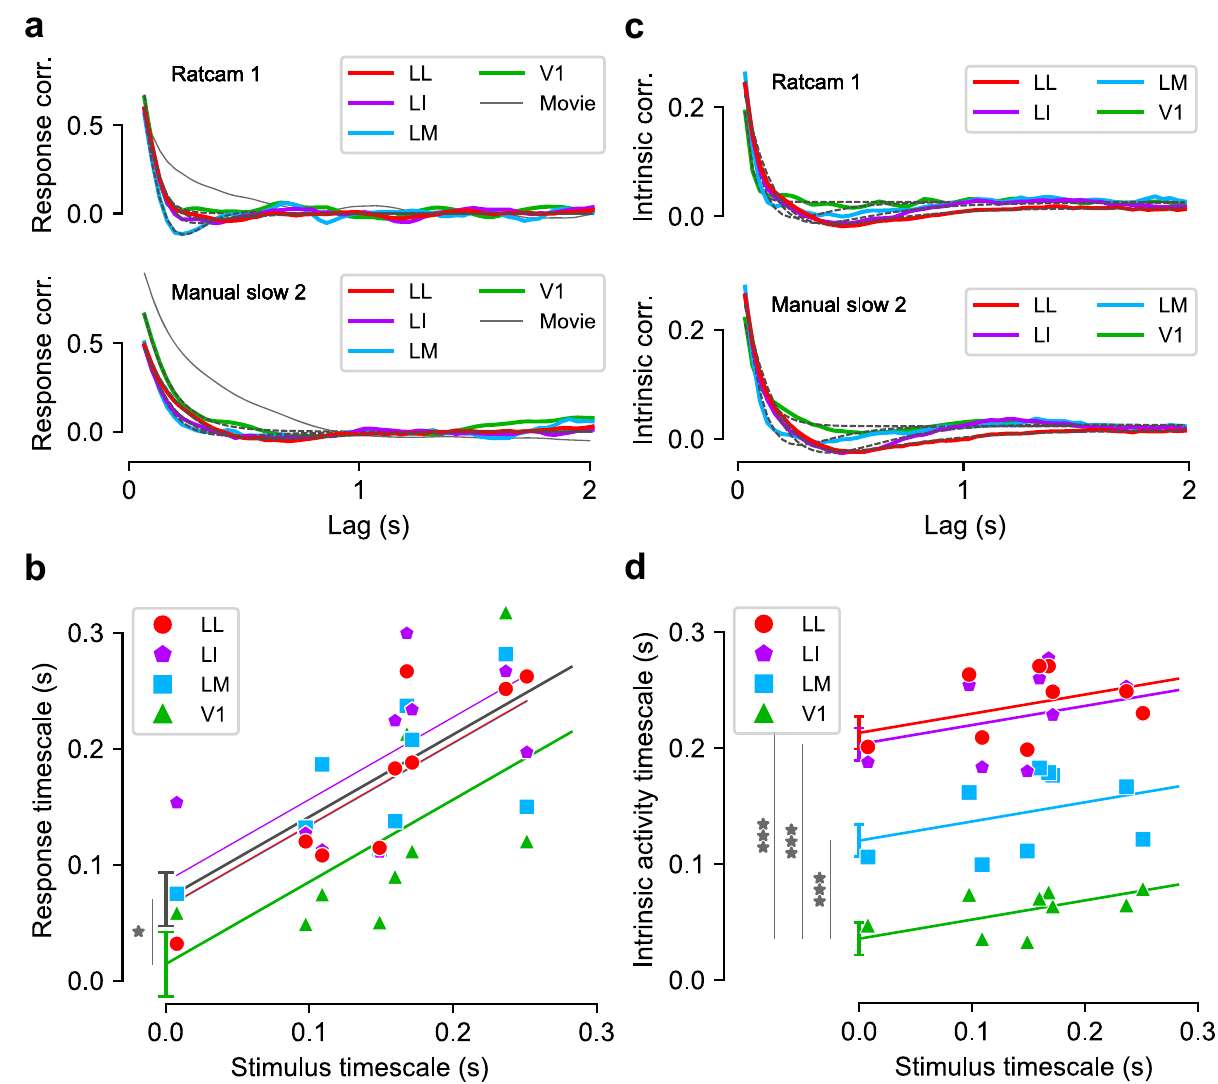
Fig. 4 Characteristic timescale of the stimulus-driven population responses and of the intrinsic neuronal activity. a Correlation between pairs of population response vectors (as those highlighted by the yellow frames in Fig. 3c) as a function of their temporal lag for two example movies (solid, colored lines). These curves were fi tted with either an exponential decay or a damped oscillation function ( fi ts are shown as black dashed lines). The time constants of these fi ts were taken as the characteristic timescales of the population responses. The solid gray lines show the correlation functions of the corresponding movies, reported from Fig. 3b for comparison. b Timescales of the population responses as a function of the timescales of the corresponding movie stimuli (colored markers). Each colored line is the linear fi t prediction of the relationship between such timescales for a given area (same color-code as in the key; note that the lines for LM and LL are partially overlapping). The gray line is the linear fi t prediction obtained by pooling together the data of the three extrastriate areas (i.e., LM, LI, and LL). Error bars: standard error of the intercept of the linear fi ts for V1 and the pooled extrastriate areas from regression analysis (see main text), N = 36 independent combinations of movies and areas. * p = 0.015, two-tailed t -test, no multiple test correction (see main text and “ Methods ” for details). c , d Same as a and b , but for the intrinsic timescales of neuronal activity (see main text for details). *** p = 5e − 7, 1e − 13, 2e − 14, respectively, for LM, LI, LL. Source data are provided as Source Data fi